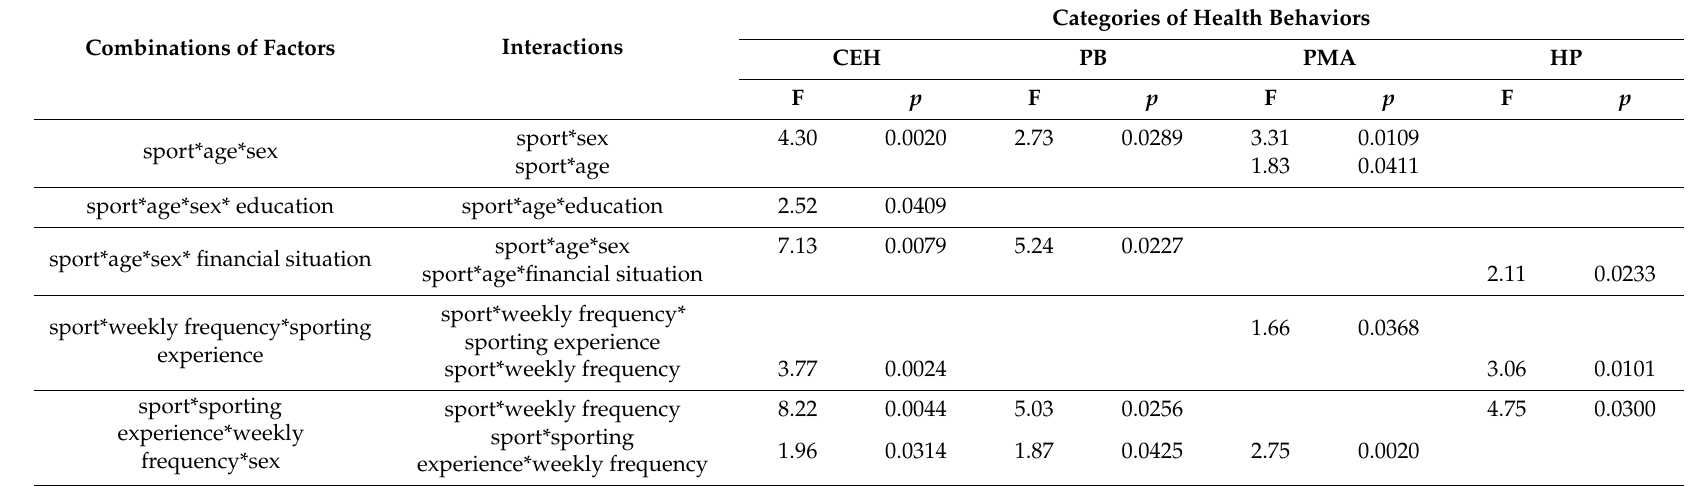
Table 8. Statistically significant interactions between the selected health behavior categories (confirmatory factor